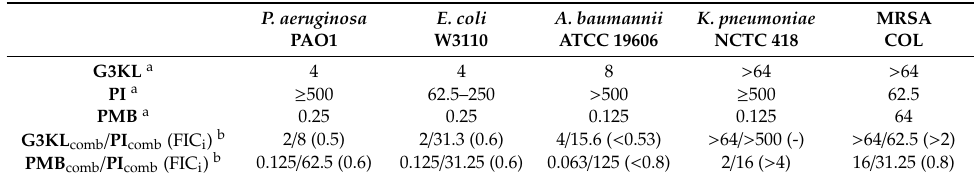
Table 1. Activity of G3KL and PMB in combination with PI